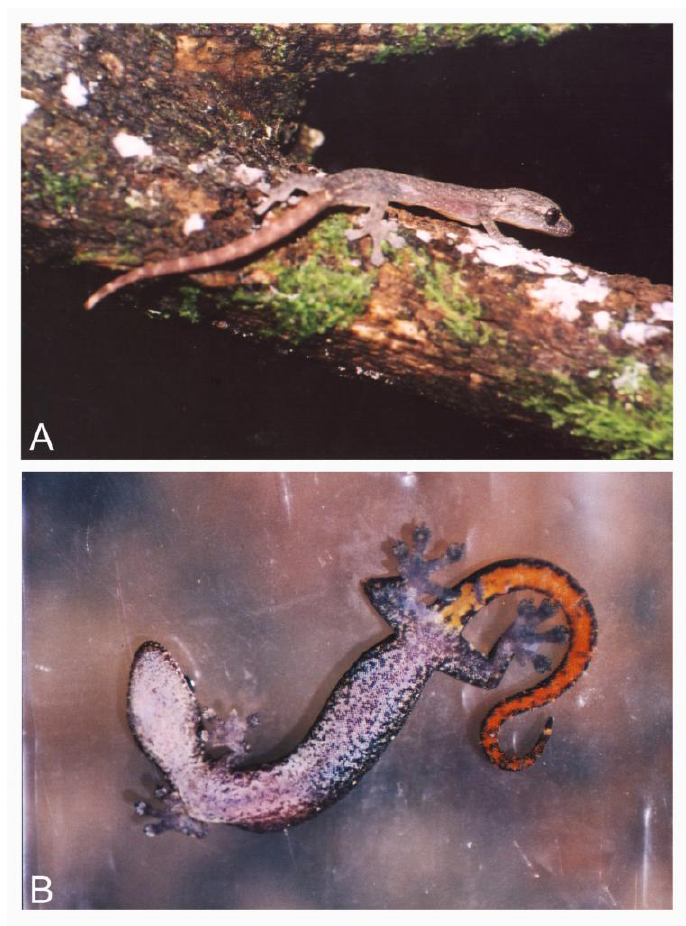
Figure 2: A, B: Juveniles of Hemiphyllodactylus typus from Morankanda Mukalana (loc. 18). The black caecum characteristic mainly for unisexual species is visible